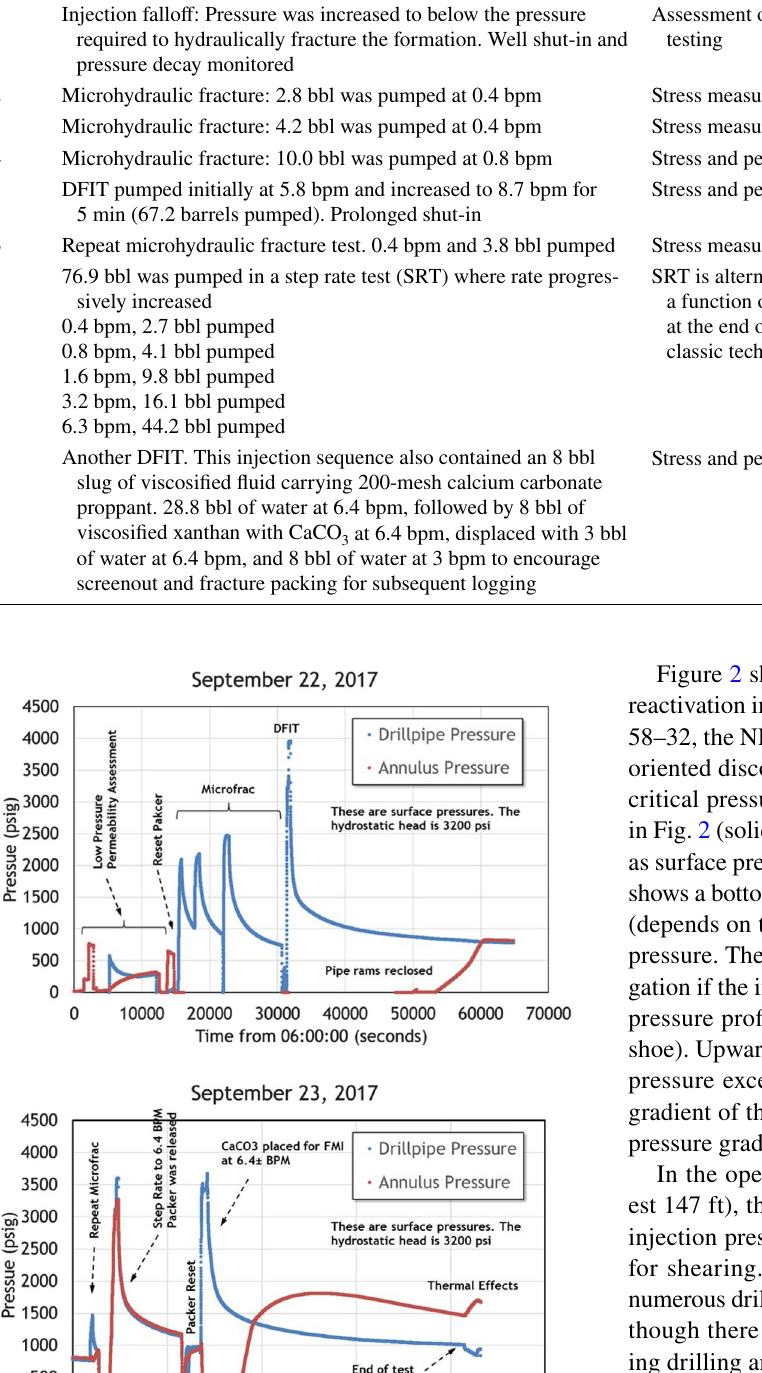
Table 1 Summary of stress and permeability measurements Cycle Description